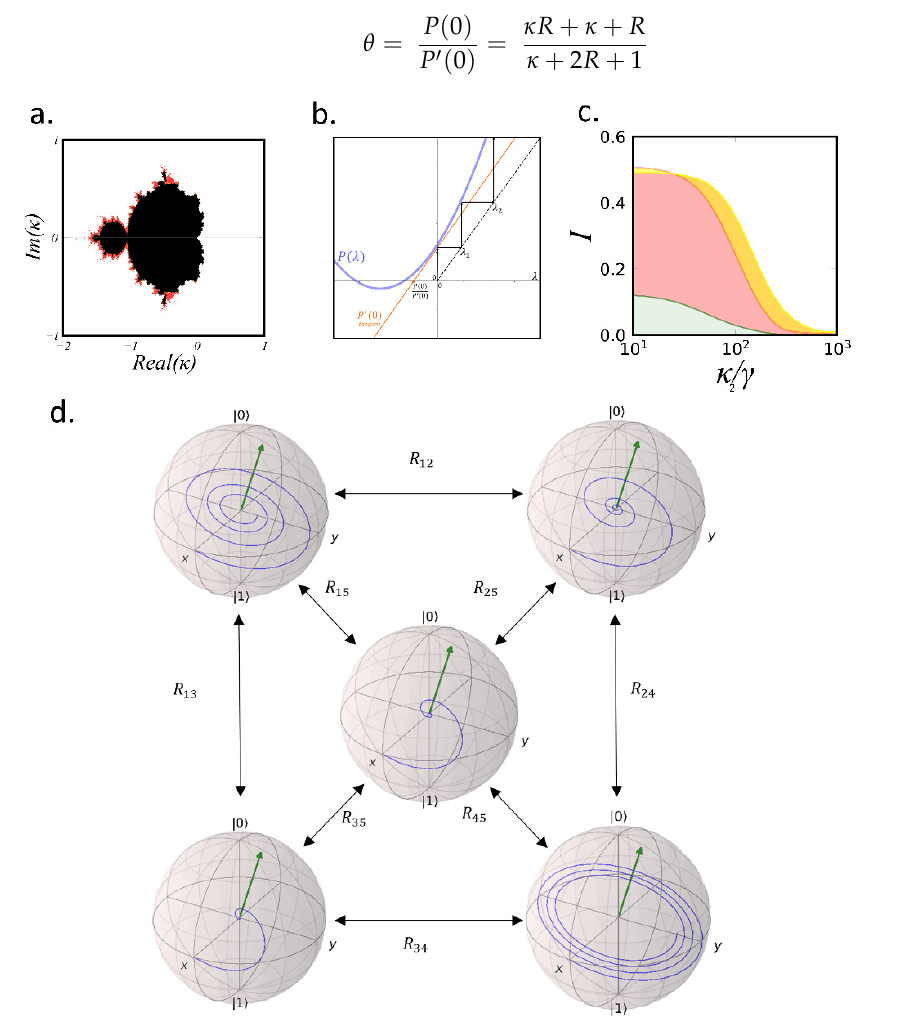
Figure 2. ( a ) κ -parameter space of the stability of rate equations of a single QE system coupled to a cavity. Black dots correspond to bounded points while the gradient colors represent the degree of stability. ( b ) Characteristic equation of (2) (blue line); tangent line with slope P (cid:48) ( 0 ) . The cut of the tangent line with the x-axis is given by P . The arrows indicate consecutive λ n values of the iteration process. ( c ) Indistinguishability versus normalized κ 2 for g = (green), 2 γ (red) and 3 γ (yellow). ( d ) Bloch-spheres of the five-QE system with population rate transfers R ij between each sub- system.